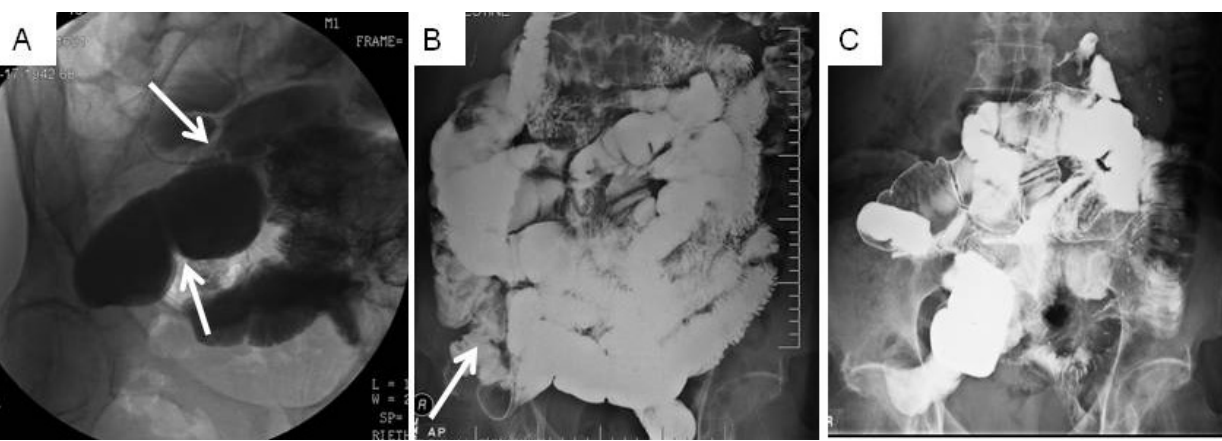
Figure 1. Small bowel radiographs of Patient 1 documenting SBO resolution over time. Arrows note areas of obstruction. ( A ) Before therapy in 2011: incomplete SBO due to adhesions visualized by X-ray showing dilation of the proximal mid ileum. ( B ) Twelve months after therapy in 2012: mild stricture at the terminal ileum with no other small bowel abnormalities. ( C ) After 40 h of therapy: normal small bowel series X-ray in